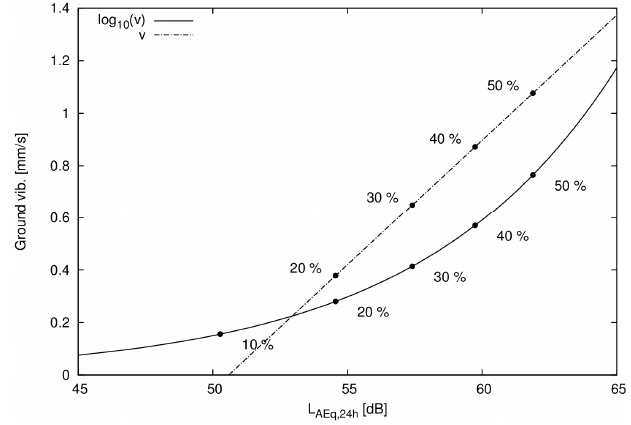
Figure 4. Function of equal annoyance for noise and vibration both for a linear and logarithmic model, percentages indicate probability of being annoyed either by vibration or noise.